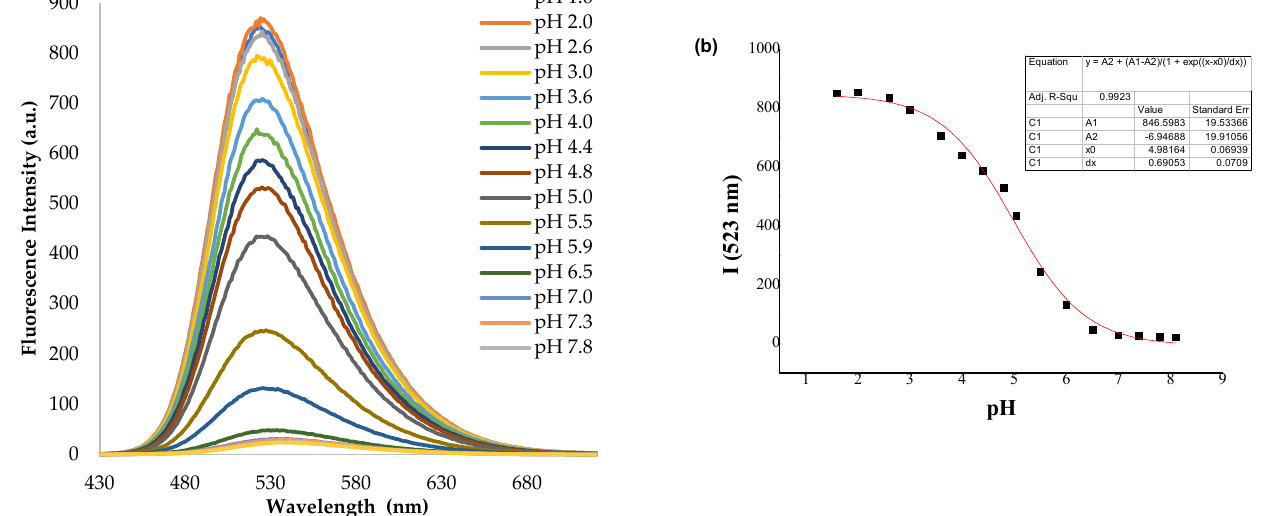
Figure 3. ( a ) Fluorescence spectra of NI-1 in buffer methanol mixture (2:1) at different pH; ( b ) flu- orescence intensity at 523 nm vs. pH.